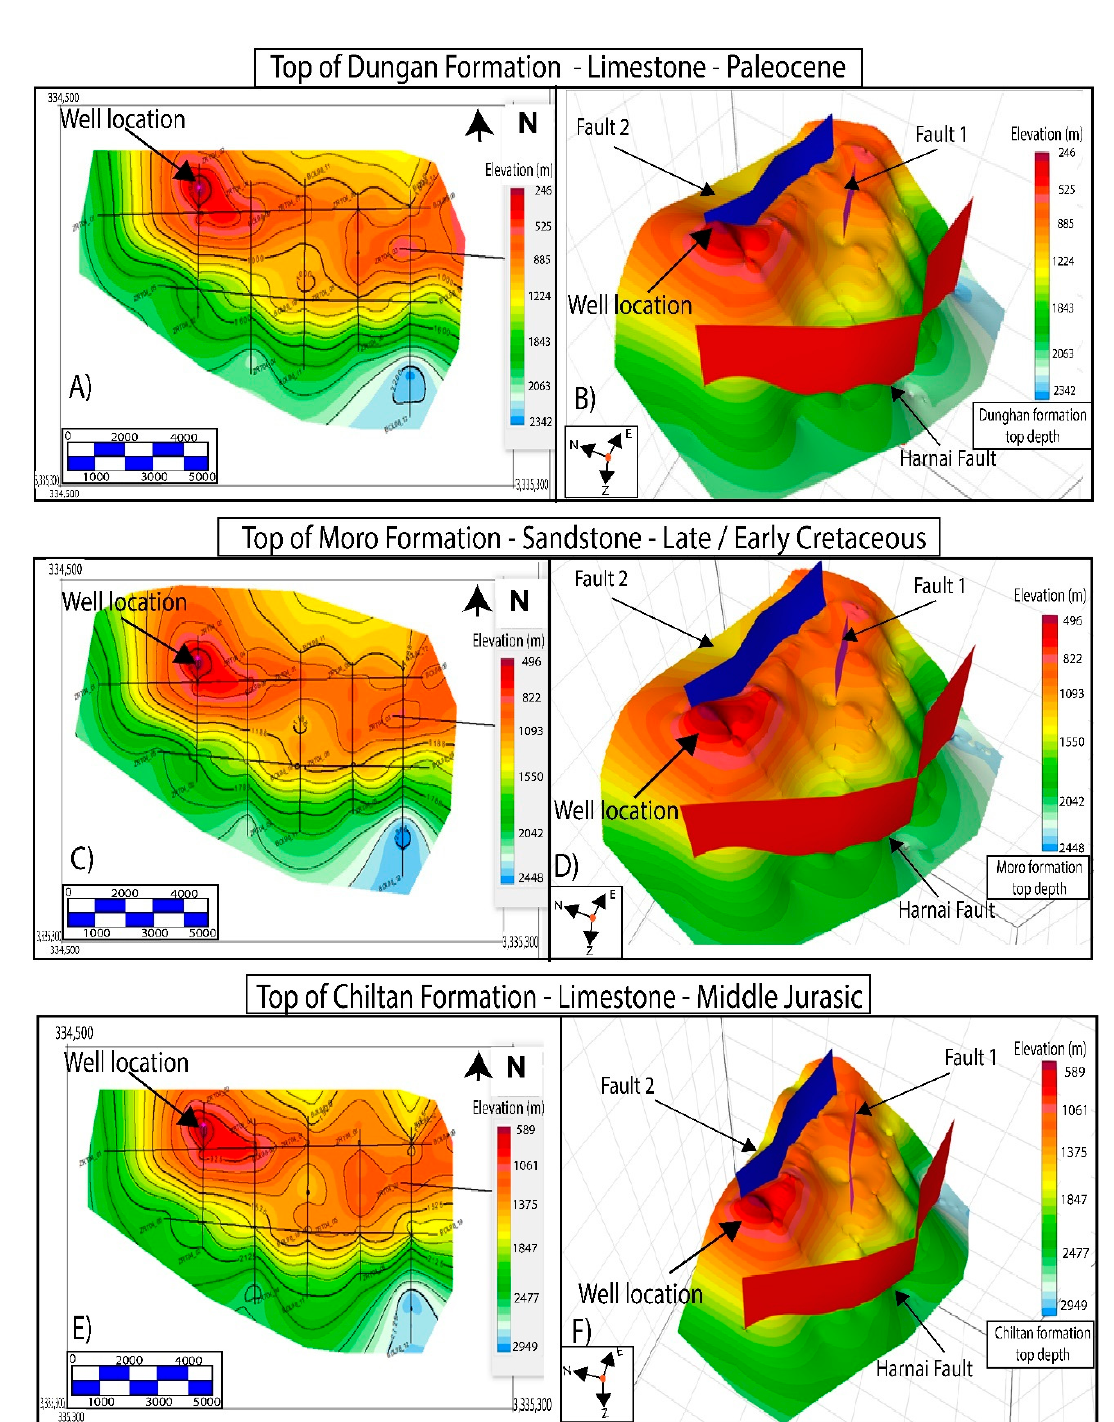
Figure 13. Formation tops of the Dunghan, Moro, and Chiltan Formation. ( A , C , E ) show a 2D depth contour map of the Dunghan Formation, Moro Formation, and Chiltan Formation, respectively. The ages of these formations are Paleocene, Late/Early Cretaceous, and Middle Jurassic, respectively. ( B , D , F ) show the 3D depth surface of the Dungan Formation, Moro Formation, and Chiltan Formation.